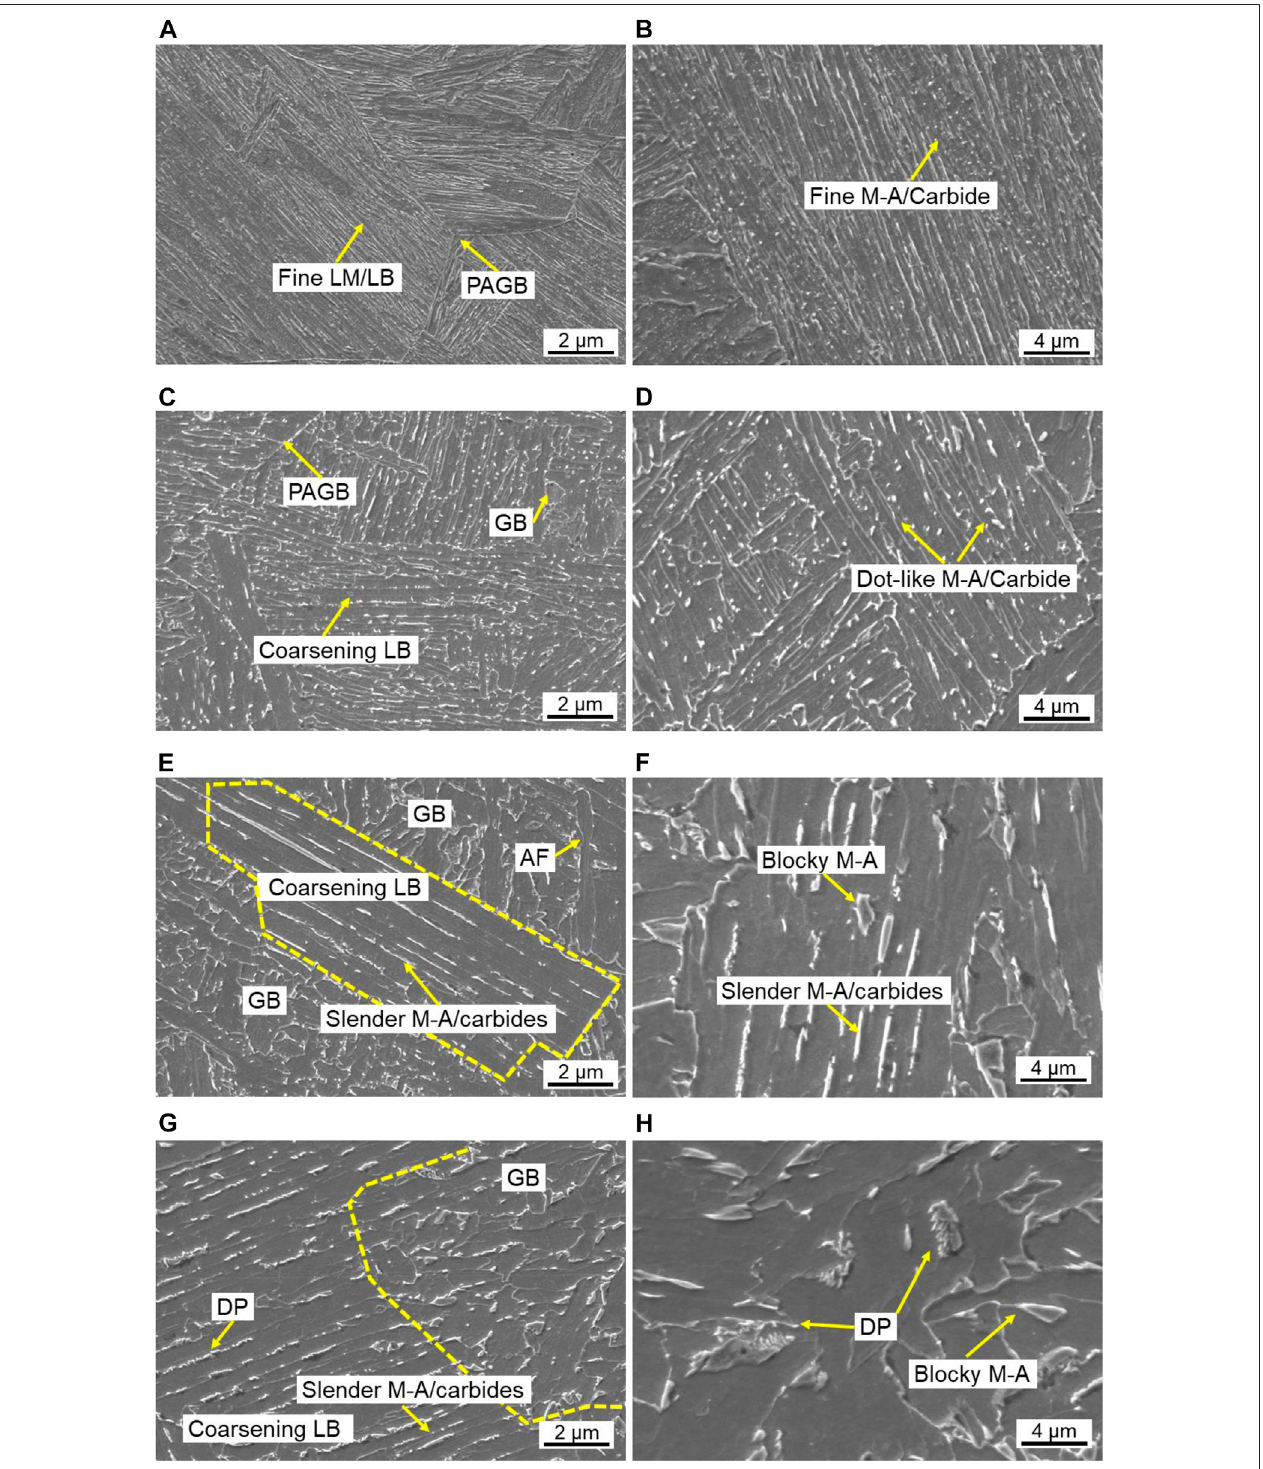
FIGURE 5 | SEM micrographs of microstructures in the CGHAZ at the heat inputs of (A, B) 50, (C, D) 100, (E, F) 150, and (G, H) 200 kJ/cm.